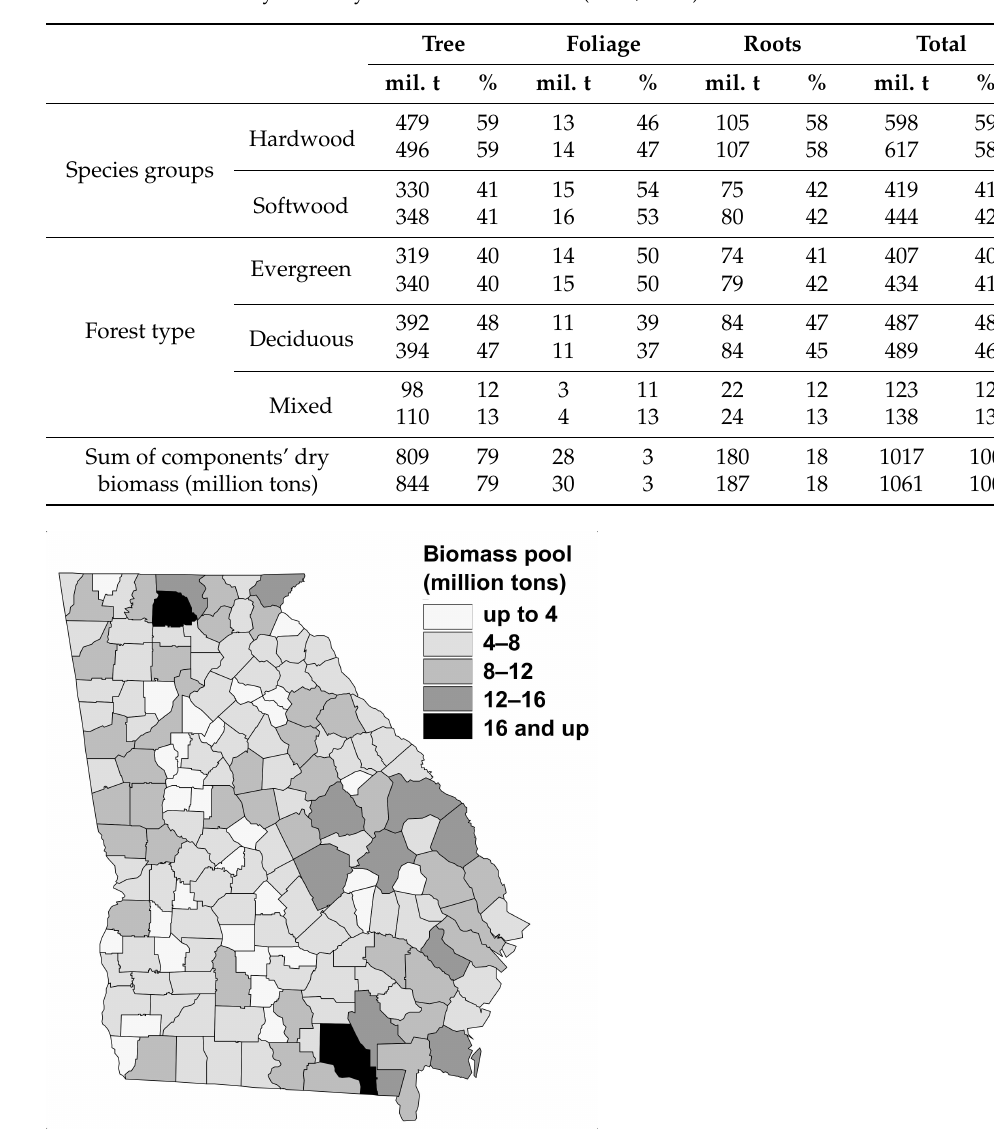
Figure 2. Biomass pools (t) on county level of resolution in